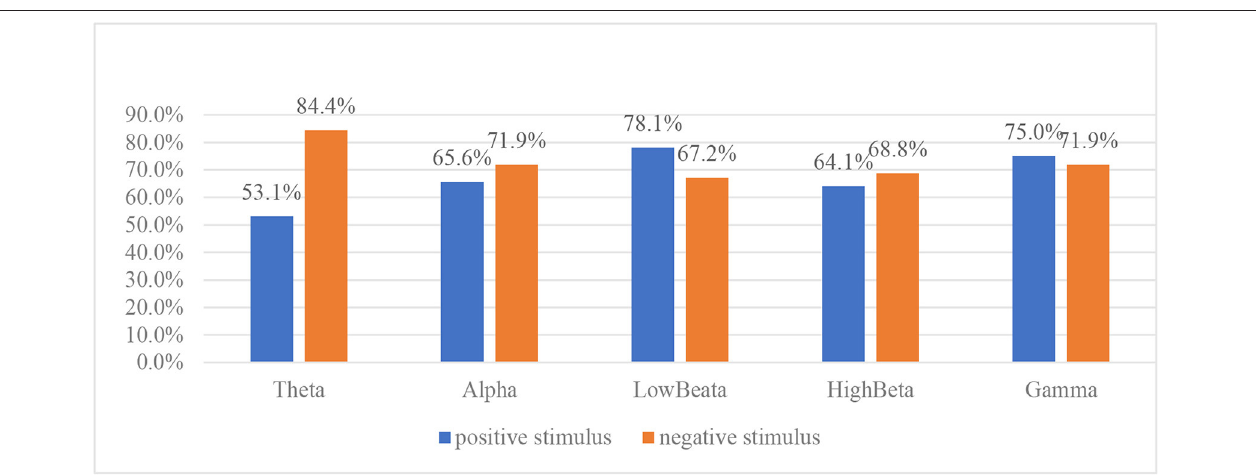
emotional stimulus, and 87.5% when λ = 0.24 under negative emotional